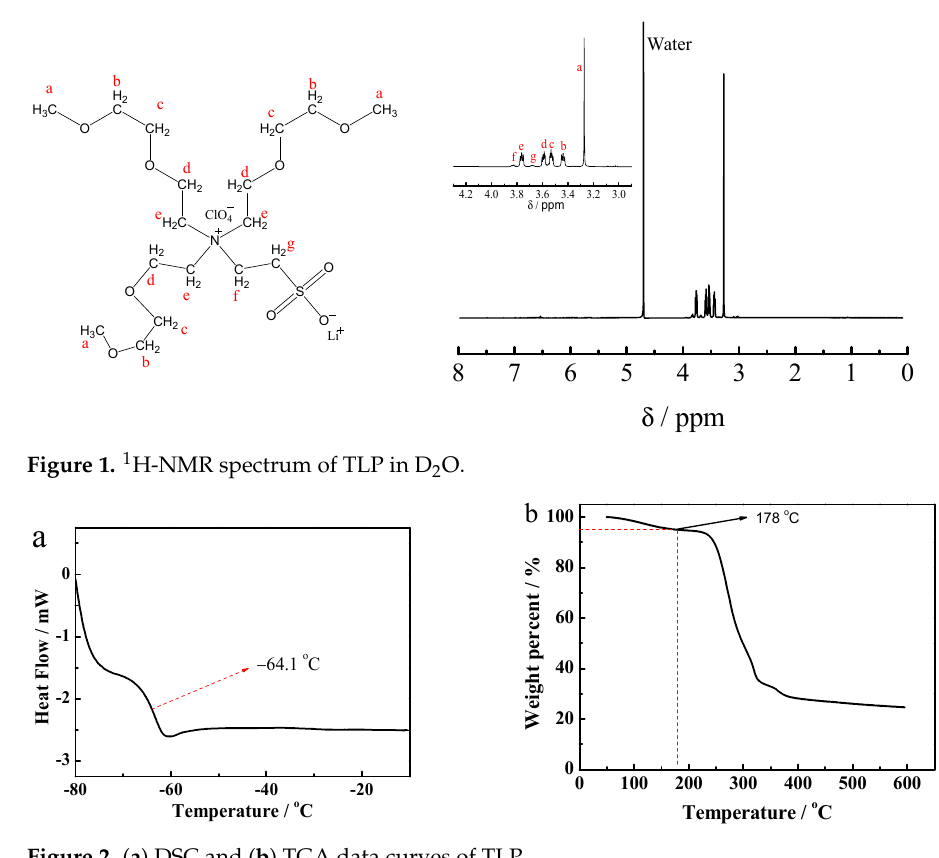
Figure 2. ( a ) DSC and ( b ) TGA data curves of TLP.